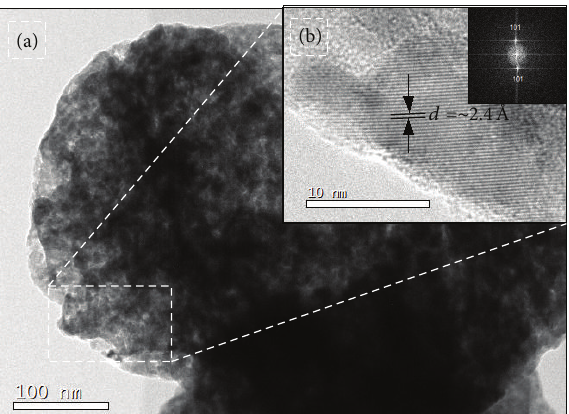
Figure 6: TEM and HRTEM images of ZnO nanoparticles synthesized from precursor solution concentration of (a) 0.1M and (b) the inset is the corresponding FFT pattern of HRTEM